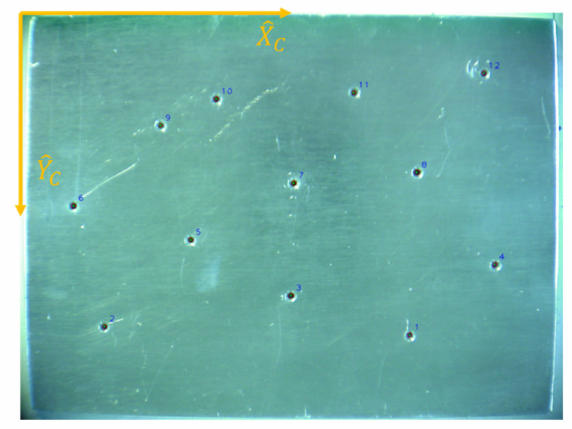
Figure 5. Processed image and the coordinate system { C